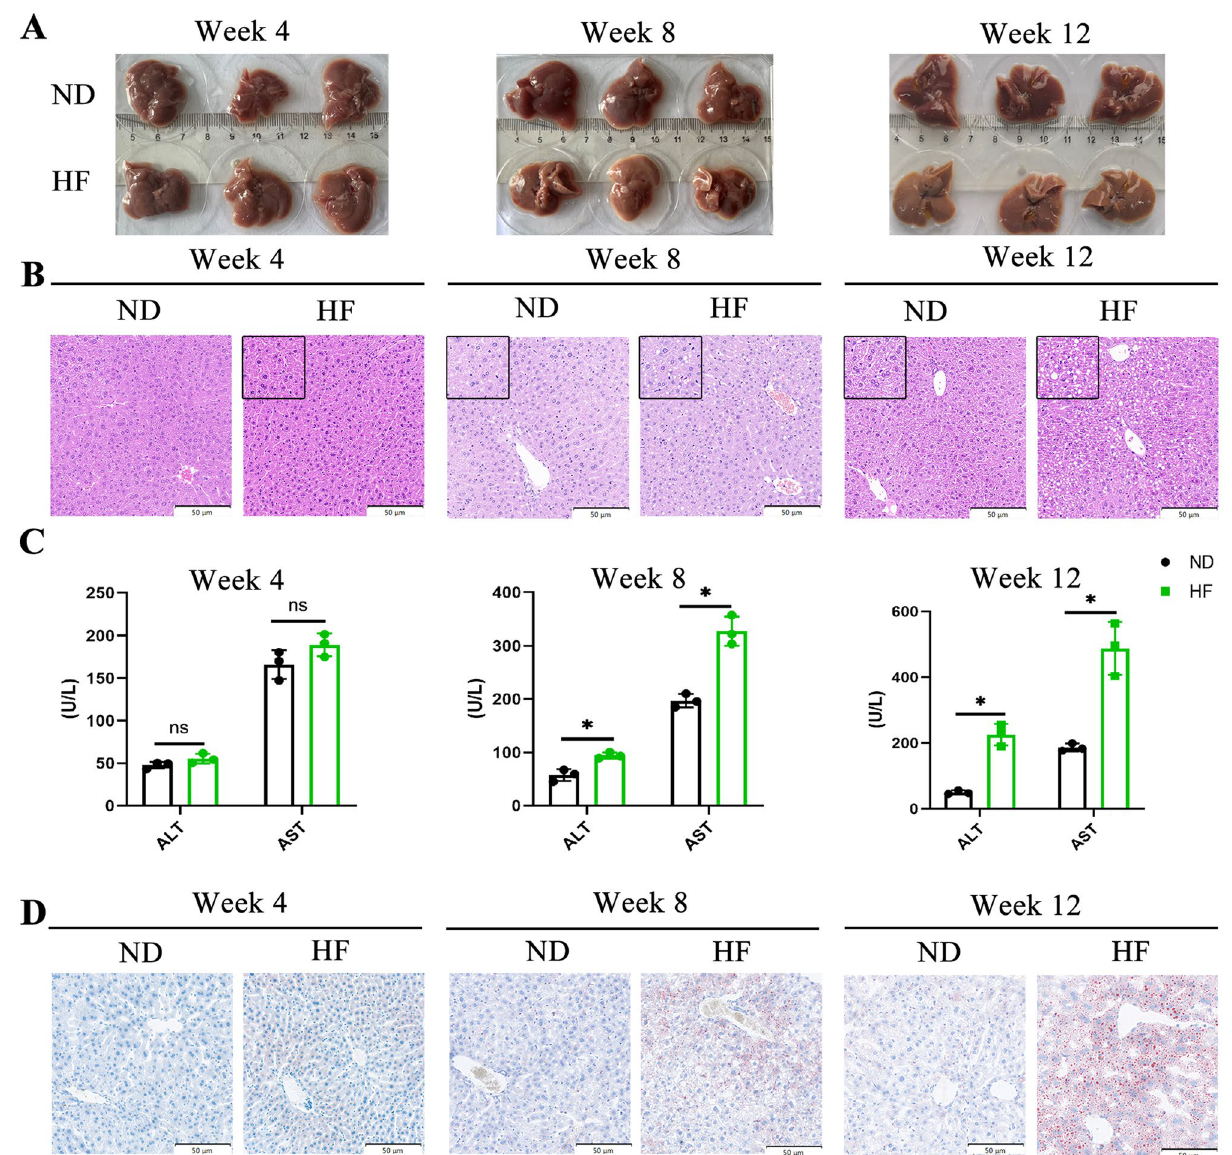
Figure 2. Effects of HF diet on liver morphology, liver histopathological features, serum ALT and AST activities and hepatic lipid accumulation of mice. ( A ) Comparison of liver morphology both two groups of mice at 4, 8, and 12 weeks; ( B ) H&E staining of liver sections. Bar: 50 µm. ( C ) Effect of high fructose on serum ALT and AST activity; ( D ) Oil-Red O staining of liver sections. Bar: 50 µm. The student’s t-test was used to determine statistical significance. * p <